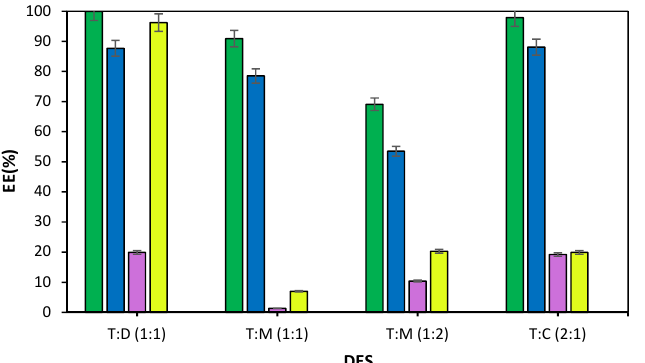
Figure 1. Extraction efficiency for each DES, starting out with a 100 mg L − 1 dye concentration, for MG (green), BBG (blue), AV43 (violet) and AY27 (yellow). Dyes can form hydrogen bonds with water and with DES. Consequently, their hy- drogen bonds acceptor (HBA) and hydrogen bonds donor (HBD) counts should be related to the extraction efficiency, even though there are other contributing factors such as chain flexibility and aromaticity. Menthol and thymol have a hydroxy group that serves both as HBD and HBA. Decanoic acid has another -OH group with the same behavior, plus an- other HBA count in the oxygen atom present in the carboxyl group. Coumarin has two HBA counts in the two oxygen atoms present in the molecule, as seen in Table S1. Accord- ing to that, the DES constituted by thymol and decanoic acid still has one HBD and two HBA available to form hydrogen bonds with dyes, facilitating dye extraction. This fact could explain the better results obtained with T:D (1:1). However, the formation of hydro- gen bonds between the dye and water hampers the extraction, so it is expected that dyes with higher HBA and HBD counts will be more difficult to extract. The HBD counts of these dyes vary from zero for MG to four for DB15, while the HBA counts range from one for MG to twenty-four for RB5, with MG being the most easily extracted, while the EE for RB5 is lower than 5%. In general, an increase in HBA counts in the dye (mainly due to oxygen atoms) implies a decrease in EE. Figure 2 shows the EE obtained for all dyes using T:D (1:1) as a solvent, with an initial dye concentration of 100 mg L − 1 . Figure 2. EE of T:D (1:1).